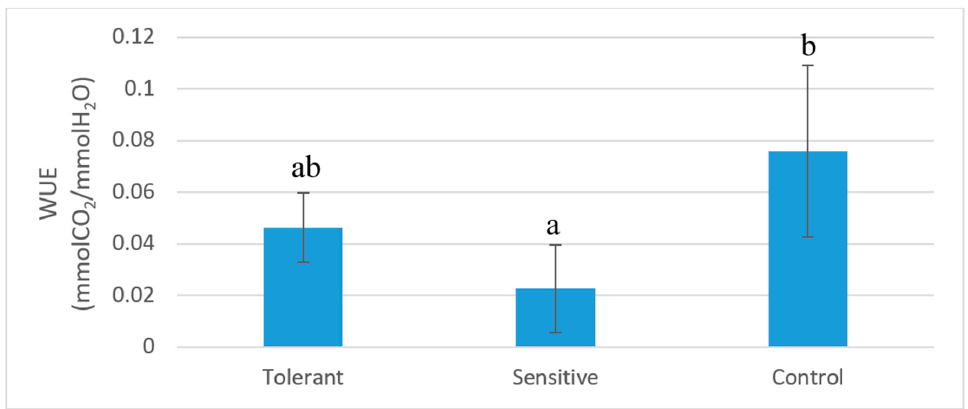
Figure 8. Water use efficiency of tolerant, sensitive, and control plants after 60 days of saline stress. Bars represent standard deviation. Different letters represent significative differences ( p < 0.05).